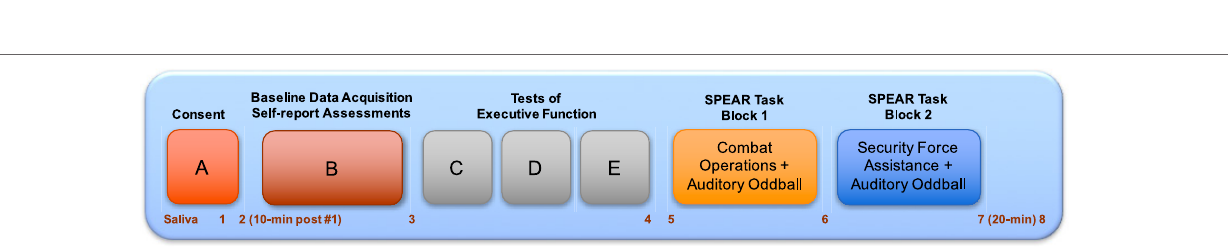
FigUre 1 | Soldier Performance and Effective, Adaptable Response (SPEAR) task design and trial structure. The initial strategic guidance (i.e., strategic context, mission statement, and commander’s intent) is provided at the beginning of a block of trials is show in the blue boxes. This is provided one time at the beginning of each block of trials. The following 18 trials occur within the context of that initial strategic guidance. The Combat Operations and Security Force Assistance blocks are illustrated as green boxes. The gray boxes illustrate the specific trial elements and auditory discrimination